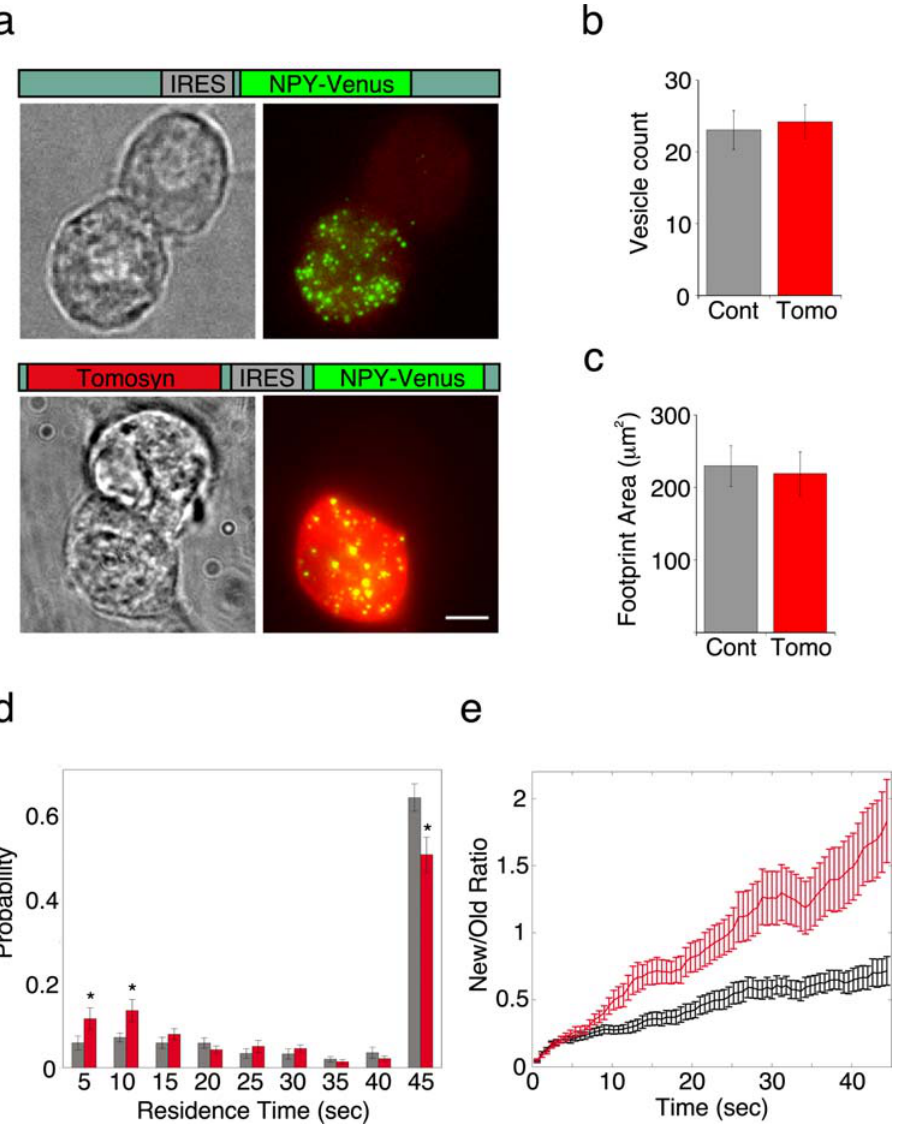
Figure 3. Vesicle residence time at the membrane is reduced and vesicle turnover is enhanced in tomosyn-overexpressing cells. (a) . Viral constructs used to express NPY-Venus alone (top) or together with tomosyn (bottom). Cells infected with each virus were fixed and immunolabeled with anti-tomosyn Ab. Shown are phase-contrast images (left) and dual-wavelength fluorescence images of NPY-Venus (green) and tomosyn Ab (red). Infection with tomosyn virus did not change the number of vesicles present near the membrane (b) or the surface area of the cells’ footprints on the coverslip (c) . (d) Histograms of vesicle residence time in control (black) and tomosyn-overexpressing (red) * p , 0.05 (student’s t- test). (e) . Average ratio between new and old vesicles for each time point in control (black) and tomosyn-overexpressing (red) cells. Statistically significant change ( p , 0.01, Mann-Whitney’s rank-sum test) was observed from t=14 s. All presented data are from 18 control and 25 tomosyn- overexpressing